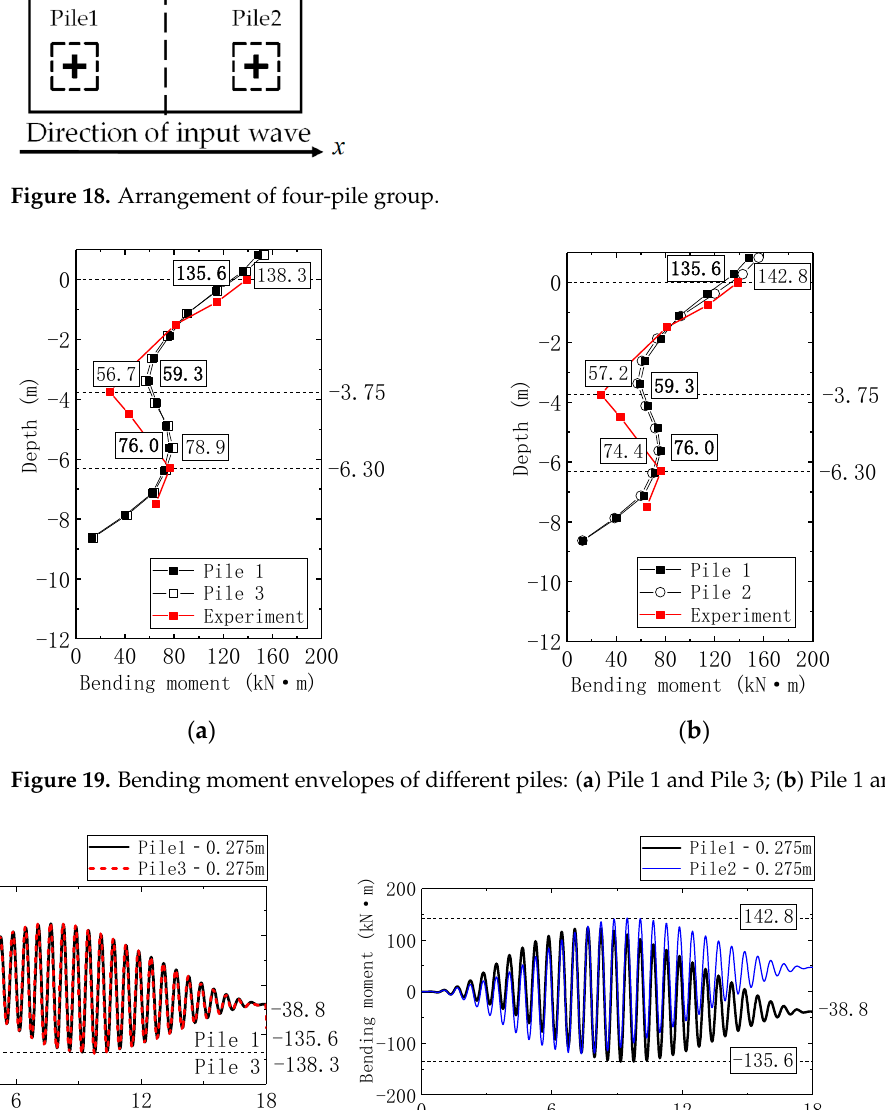
Figure 20. Time history of bending moments at 0.275 m of different piles: ( a ) Pile 1 and Pile 3; ( b ) Pile 1 and Pile 2.